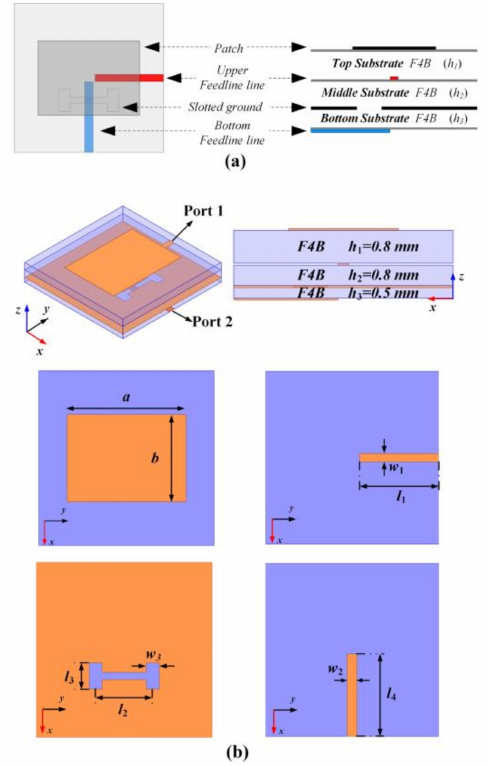
Figure 2. Geometry of the proposed dual-LP element. ( a ) Schematic diagram. ( b ) Layout and parametric illustration. The optimized dimensions are: a = 8.15 mm, b = 6 mm, w 1 = 0.56 mm, w 2 = 0.67 mm, l 1 = 5.5 mm, l 2 = 3.9 mm, l 3 = 1.8 mm, l 4 = 5.7 mm, h 1 = 0.8 mm, h 2 = 0.8 mm, and h 3 = 0.5 mm.